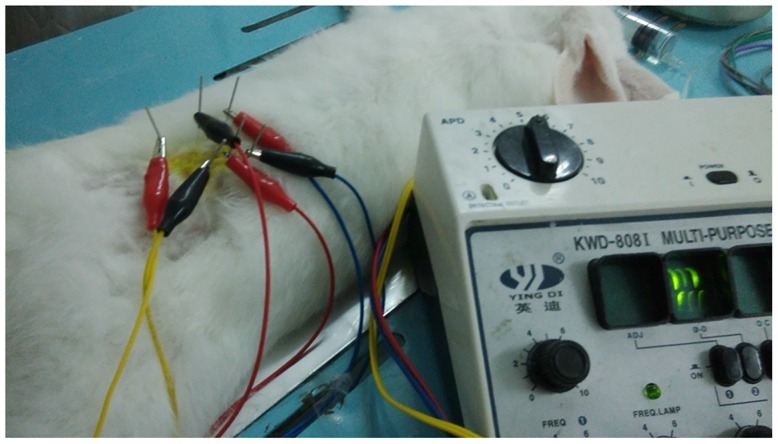
The therapy of Electro-acupuncture.The four limbs of each rabbit in the ET group were fixed on the experimental table in the prone position by a thick cotton band. Six sterile needles were inserted into each acupoint to a depth of 10-15mm. Then the needles were connected to a 3Hz/s electrical current.